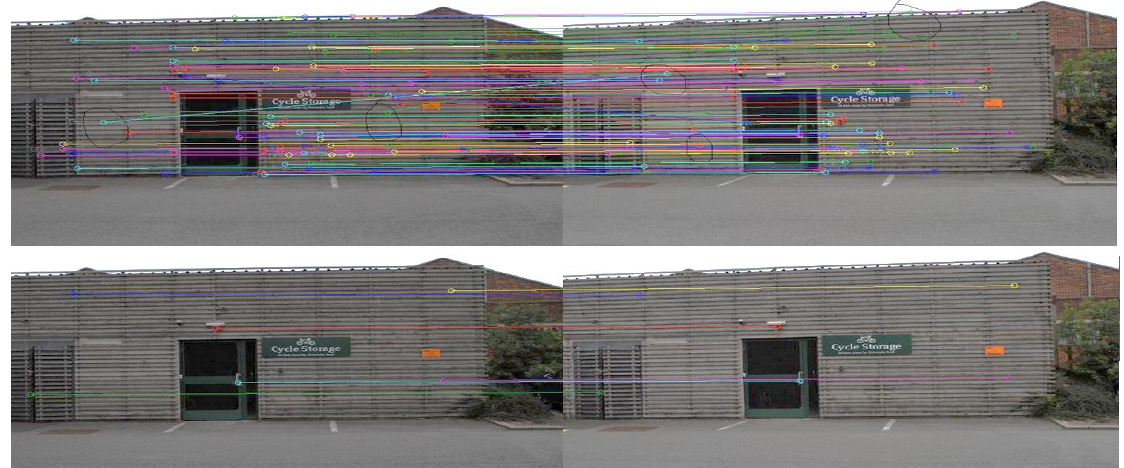
Figure 6. (top) SURF without filtering; (bottom) final common points using the modified